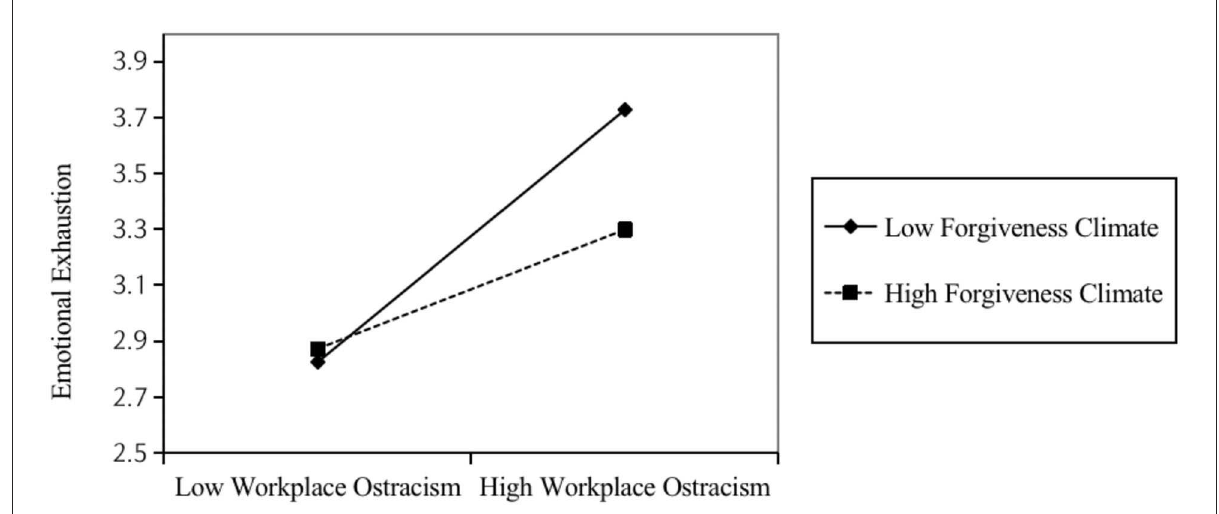
FIGURE2 Moderating role of forgiveness climate between workplace ostracism and emotional exhaustion.